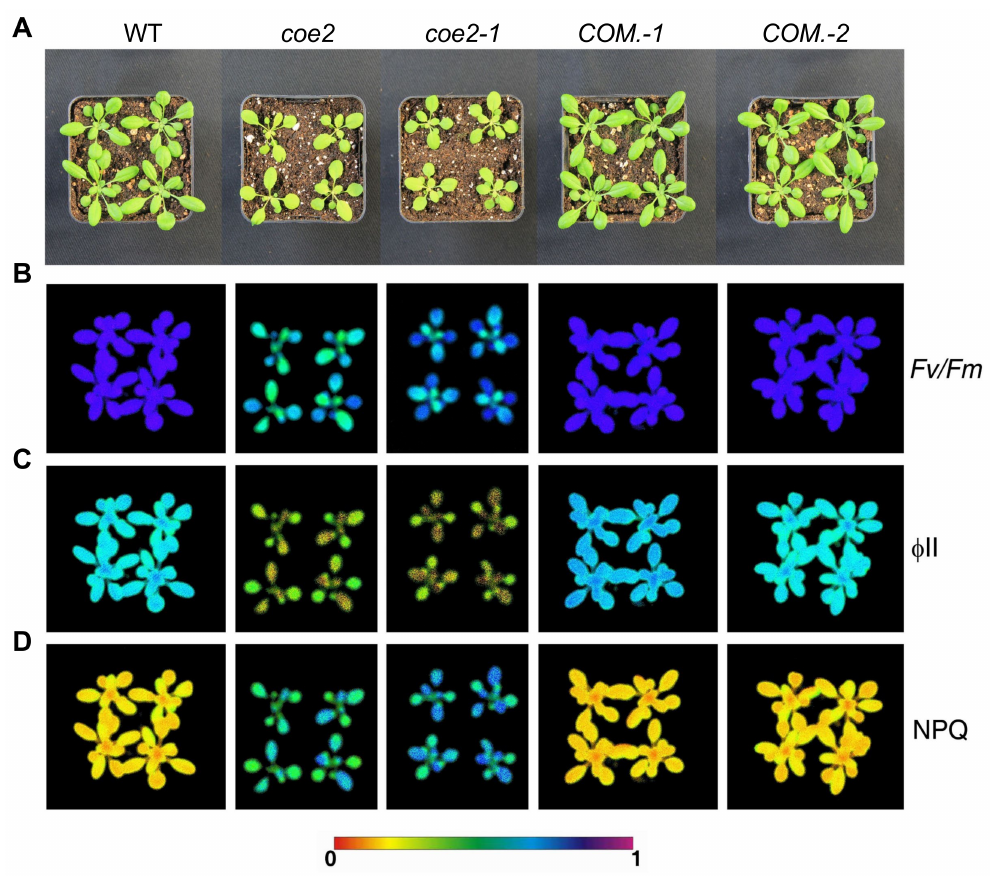
Figure 2. coe2 is defective in photosynthesis. ( A ) Growth of coe2 , coe2-1 , complemented plants of coe2-1 ( COM.-1 ), COM.-2 , and WT in soil for four weeks. ( B ) Fv/Fm, ( C ) Φ II, and ( D ) NPQ for the seedlings shown in ( A ) were measured with an imaging PAM as described in Materials and